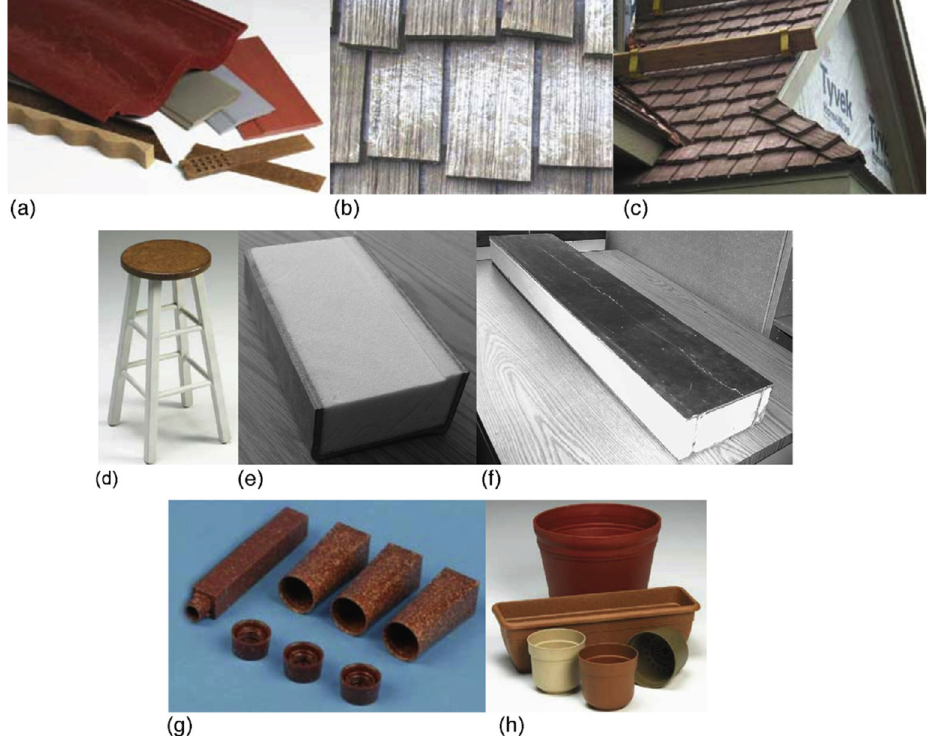
Figure 2. Examples of commercial biodegradable composites. ( a – c ) Building components [35]; ( d )